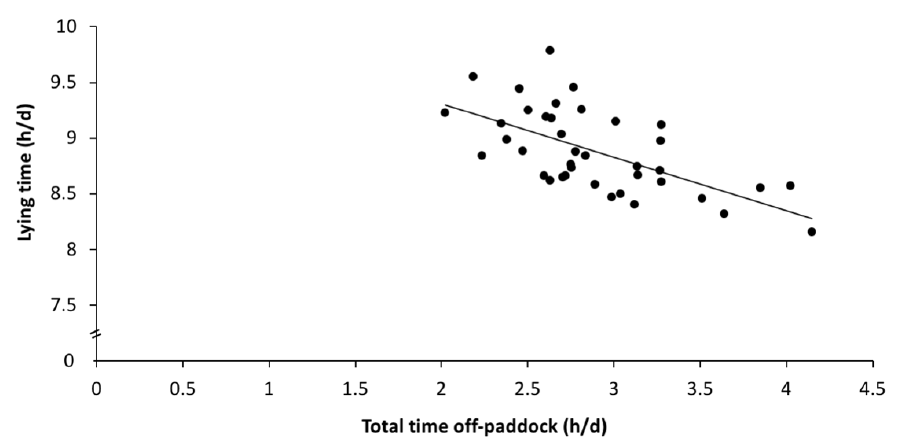
Figure 3. Regression analysis of the total time off-paddock against lying time in the paddock. The predicted values from the regression models are plotted for each of the 13 days for the 3